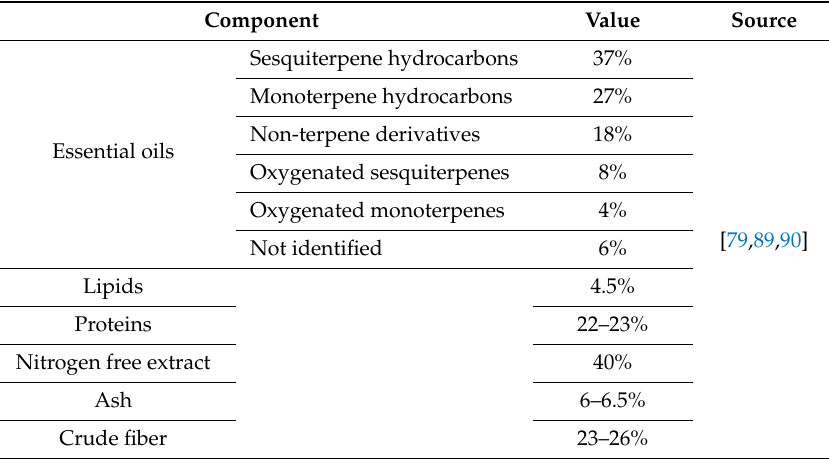
Table 4. Chemical composition of spent hops according to di ff erent